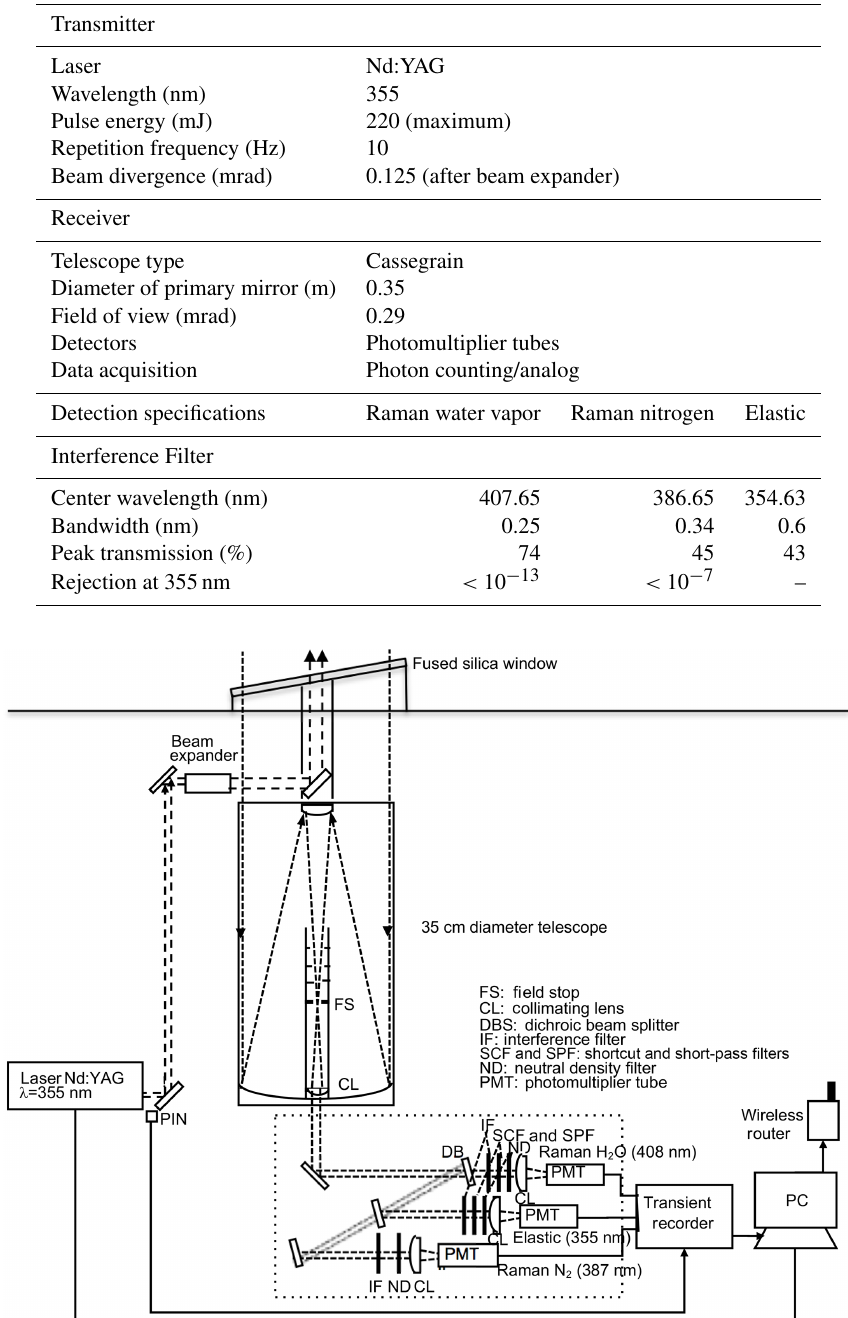
Table 1. Specifications of the mobile Raman lidar.